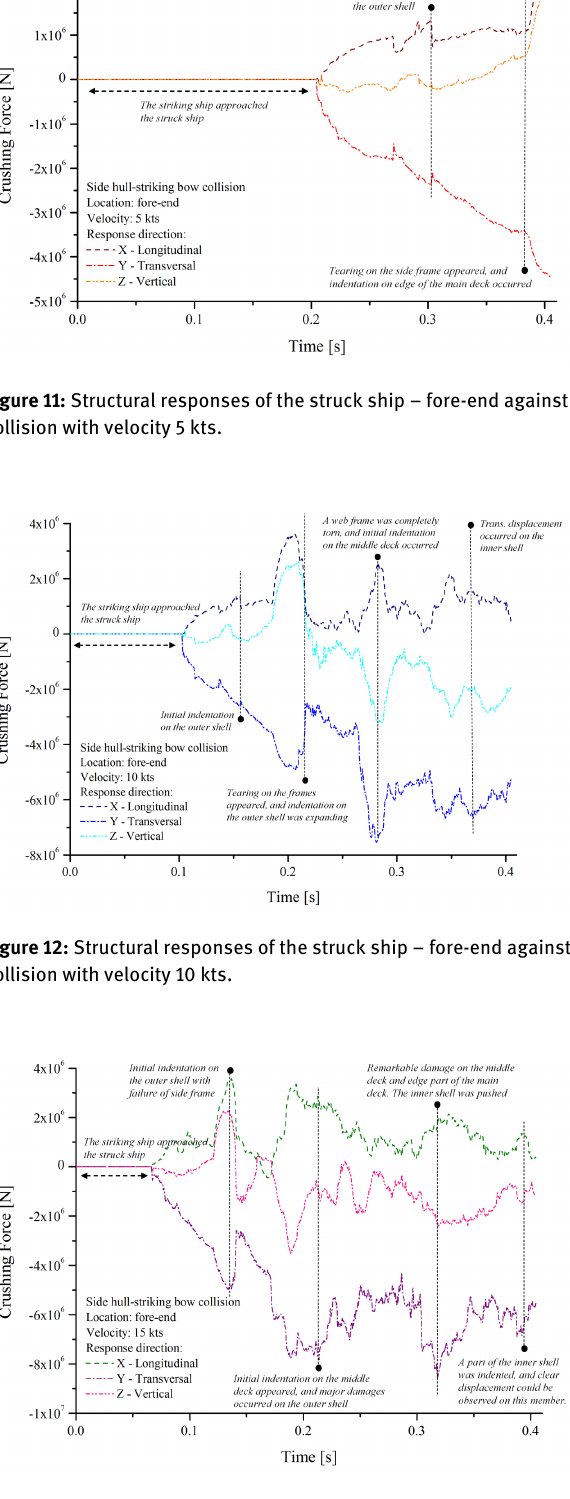
Figure 13: Structural responses of the struck ship – fore-end against collision with velocity 15